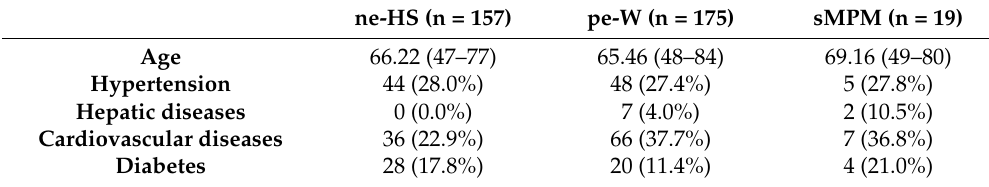
Table 1. Distribution of some physio- pathological conditions in the study population of non-exposed subjects (ne-HS), previously exposed workers (pe-W), and a subset of malignant mesothelioma patients (sMPM) for which information about concomitant conditions was available.